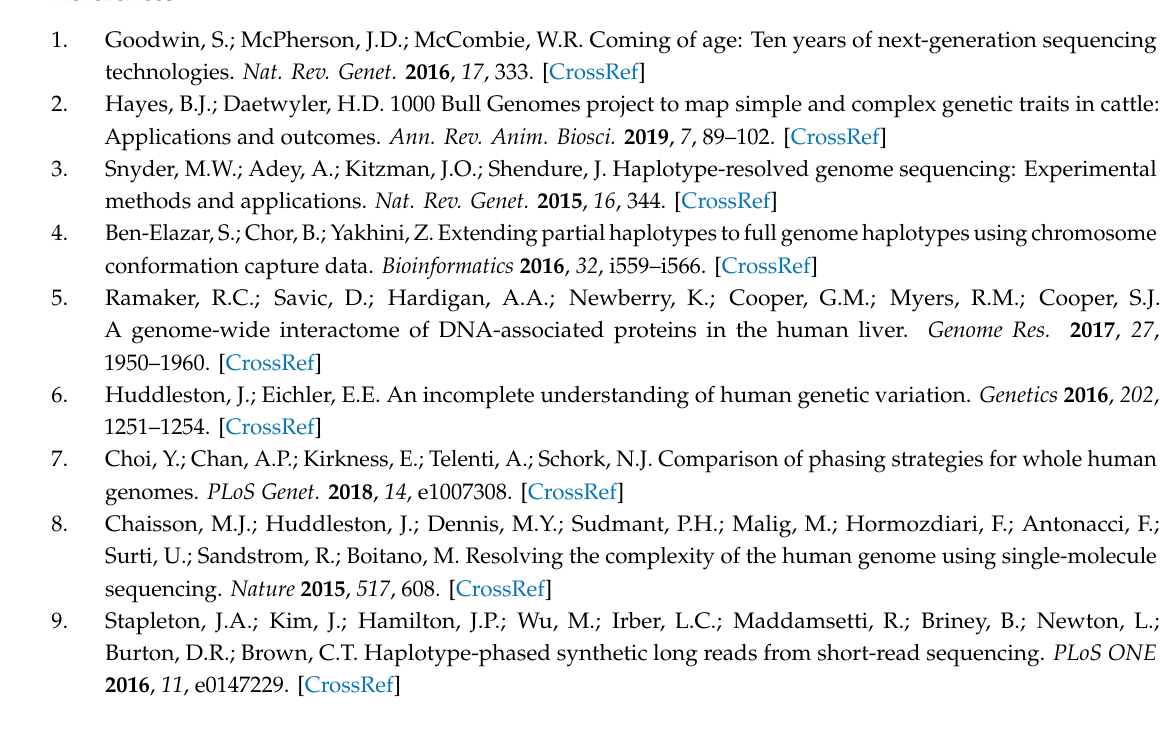
Table S1: Summary of variants identified and phased in the reference library through Illumina Synthetic Long Read